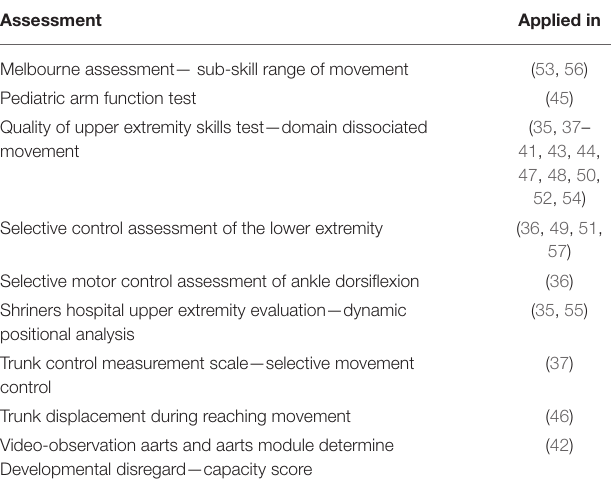
TABLE 2 | Assessments measuring